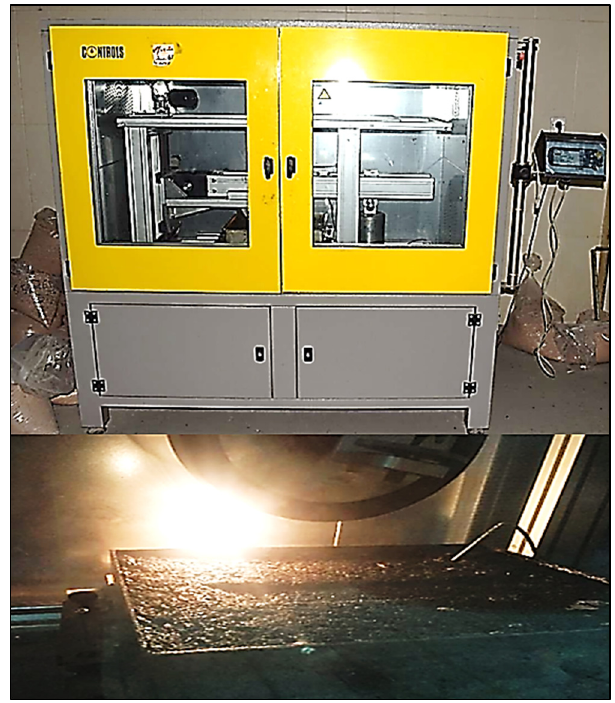
Figure 9. Operating WTT.